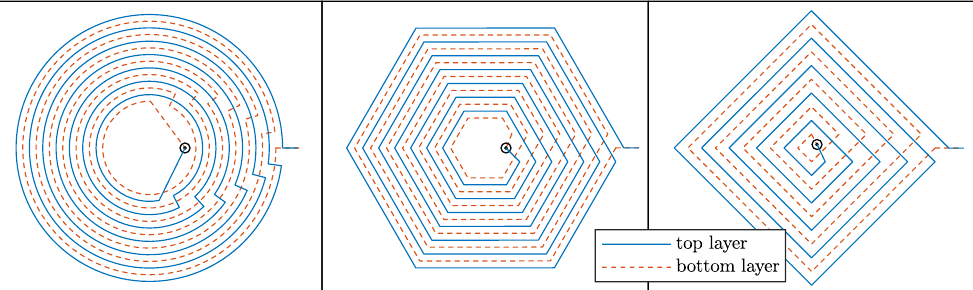
Figure 7. Optimisation provided the same value for trace width and spacing, for PCB planar coils on the centimetres scale. To minimise the parasitic capacitance of the winding, it is convenient to shift the footprints of subsequent layers, so that the traces do not